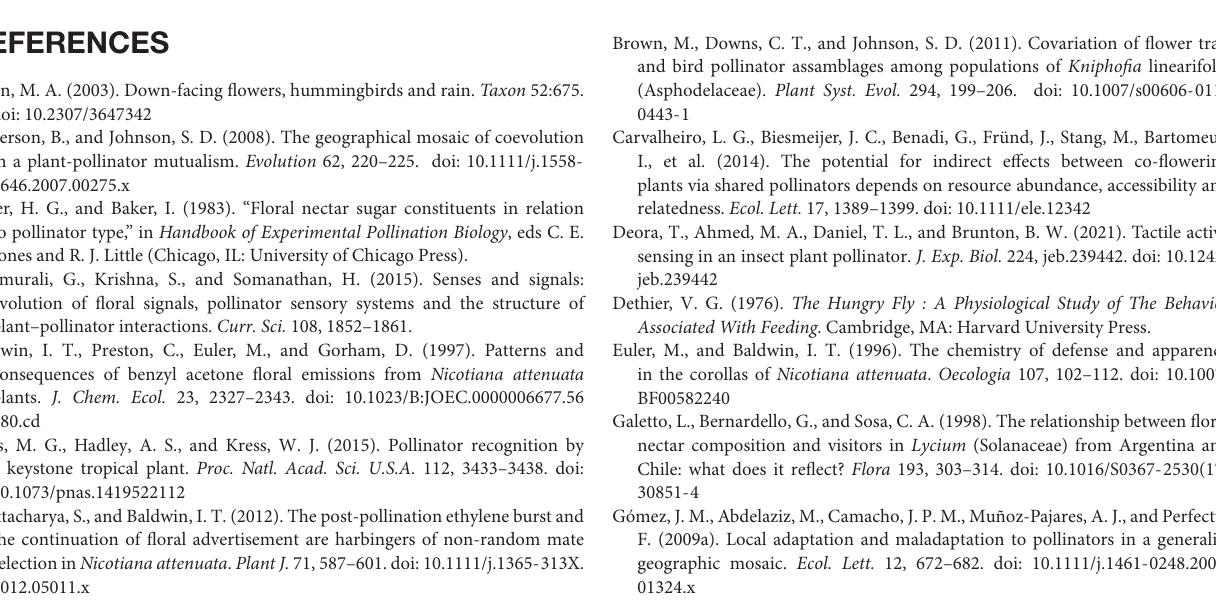
Supplementary Figure 1 | Nectar properties of four Nicotiana attenuata accessions. (A) Boxplot showing the nectar amount ( p < 0.0001). (B) Boxplot of the amount of glucose in the nectar ( F = 5.9857, p = 0.0044). (C) Boxplot of fructose amount in the nectar ( F = 6.4211, p = 0.0031). (D) Boxplot showing the amount of sucrose in the nectar ( F = 4.6708, p = 0.0139). Numbers below plot D represent replicate numbers for all nectar property measurements. Boxplots show the median, the 3rd and 4th quartile as well as the interquartile range. All data was analyzed using GLM followed by post hoc HSD with Holm adjustment. Letters indicate significant differences ( p < 0.05). Supplementary Figure 2 | Manduca sexta foraging success on four N. attenuata accessions. Plot shows the percentage of flowers on which M. sexta foraged successfully. Data was analyzed with GLM with a binomial family logit type for binary data, followed by a pairwise comparison of marginal means. Asterisks indicate statistically significant differences ( p < 0.05), dot indicates p < 0.1. Supplementary Table 1 | P -values after multicomparison of flower morphology and opening, as well as flower and capsule production after Manduca sexta visitation and flower contact time. Asterisks indicate statistically significant differences (* = p < 0.05, ** = p < 0.01, *** = p < 0.001). Supplementary Table 2 | P -values after multicomparison of phenology data on four N . attenuata accessions. Asterisks indicate statistically significant